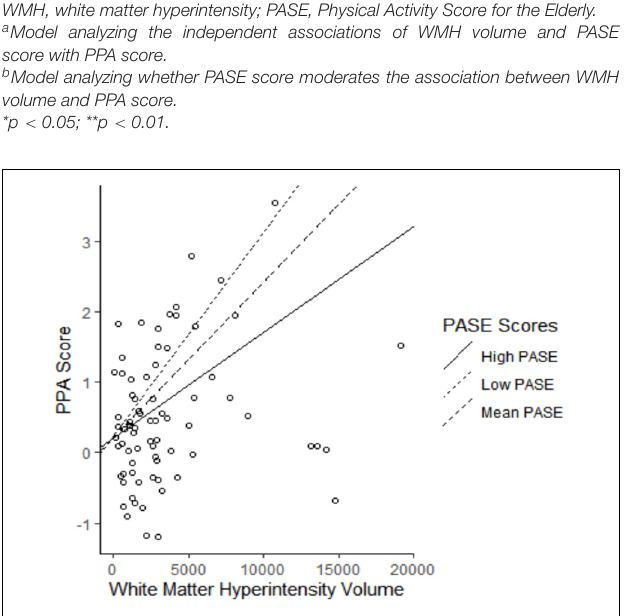
FIGURE 2 | The association of white matter hyperintensity (WMH) volume with falls risk moderated by physical activity level. Higher Physical Activity Score for the Elderly (PASE) attenuated the association between WMH volume and Physiological Profile Assessment (PPA) score (Adjusted R 2 = 5.8%). High PASE = 1 SD above mean; Low PASE = 1 SD below mean.